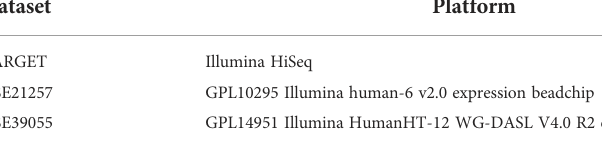
TABLE 1 Basic characteristics of the gene expression pro fi le data.